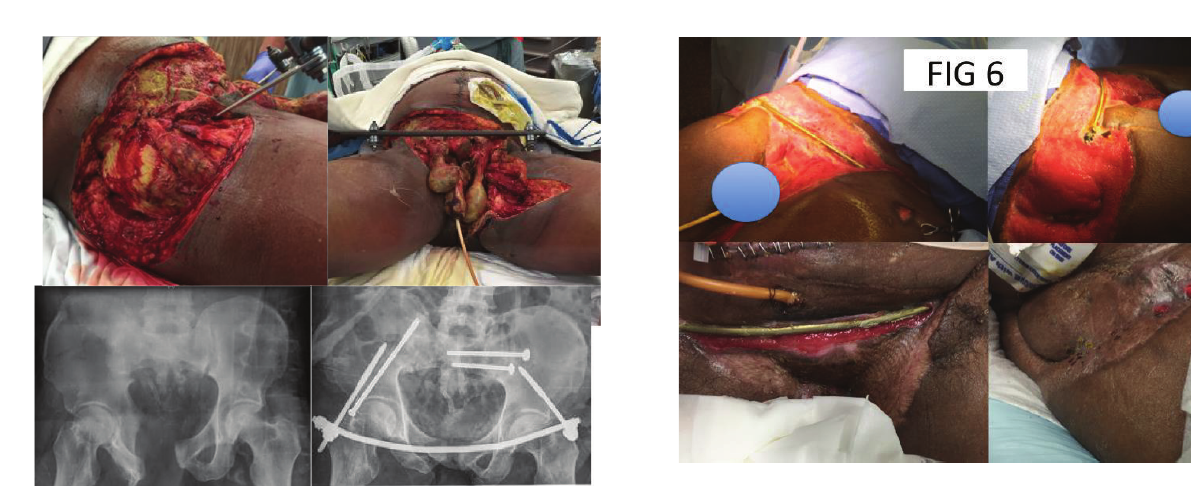
Figure 6: After fixation bowel and urinary diversion and wound